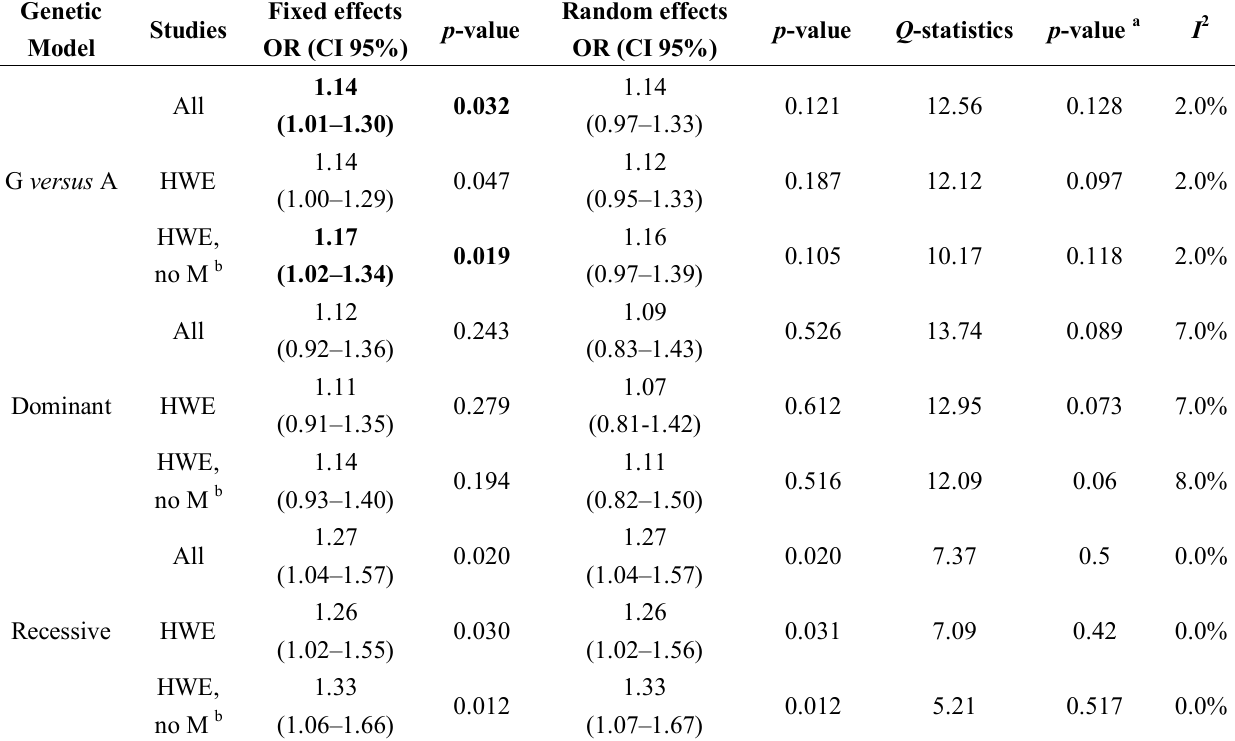
Table 3. Results of the meta-analysis.